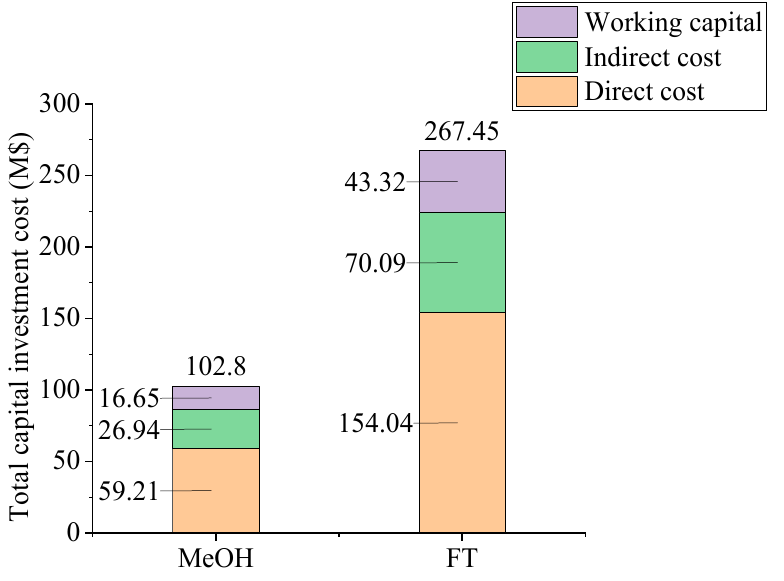
Figure 2. Total capital investment cost breakdown of methanol synthesis and Fischer–Tropsch process models (MeOH indicates the methanol synthesis process model and FT indicates the Fischer–Tropsch process model).